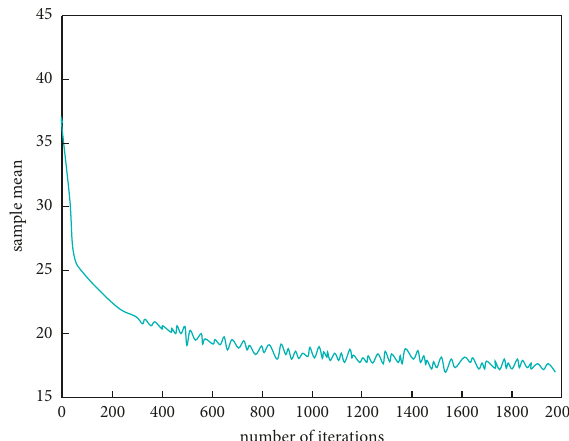
Figure 5: Convergence diagram of the Markov logic network model algorithm. Table 4: Section BSAKETS data sheet.